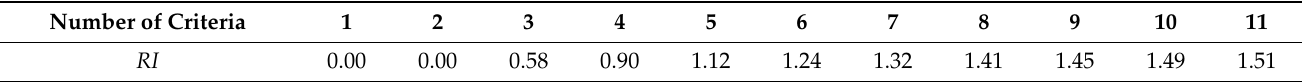
Table 2. Random index matrix